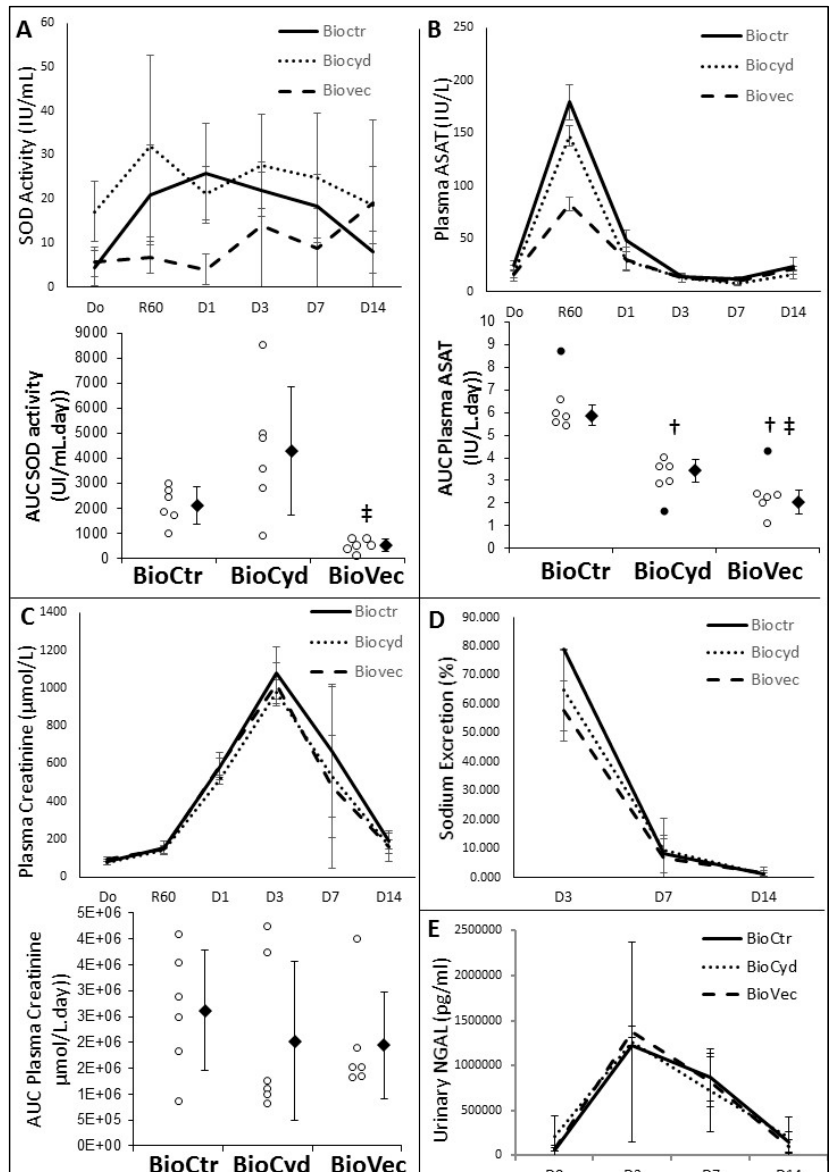
Figure 5. Evaluation of Vectisol ® benefits during machine preservation: early follow-up. The benefits of supplementation were evaluated during the first two weeks of transplantation. Several pathways were investigated: ( A ) Oxidative stress, through plasma superoxide dismutase (SOD); ( B ) cell loss, with asparagine amino transferase (ASAT); ( C ) glomerular filtration, using serum creatinine; ( D ) tubular function, through sodium excretion, and ( E ) kidney necrosis, through Neutrophil gelatinase-associated lipocalin (NGAL). Graphical evolution over the first two weeks is displayed, and AUC comparison was used to determine statistical di ff erences when applicable. Shown are each data point (empty dots), as well as mean ± SD (filled diamonds), statistics (Dunn’s Test followed by Kruskal Wallis post-hoc): † : p < 0.05 to BioCtR, ‡ : p < 0.05 to BioCyd; black dots are